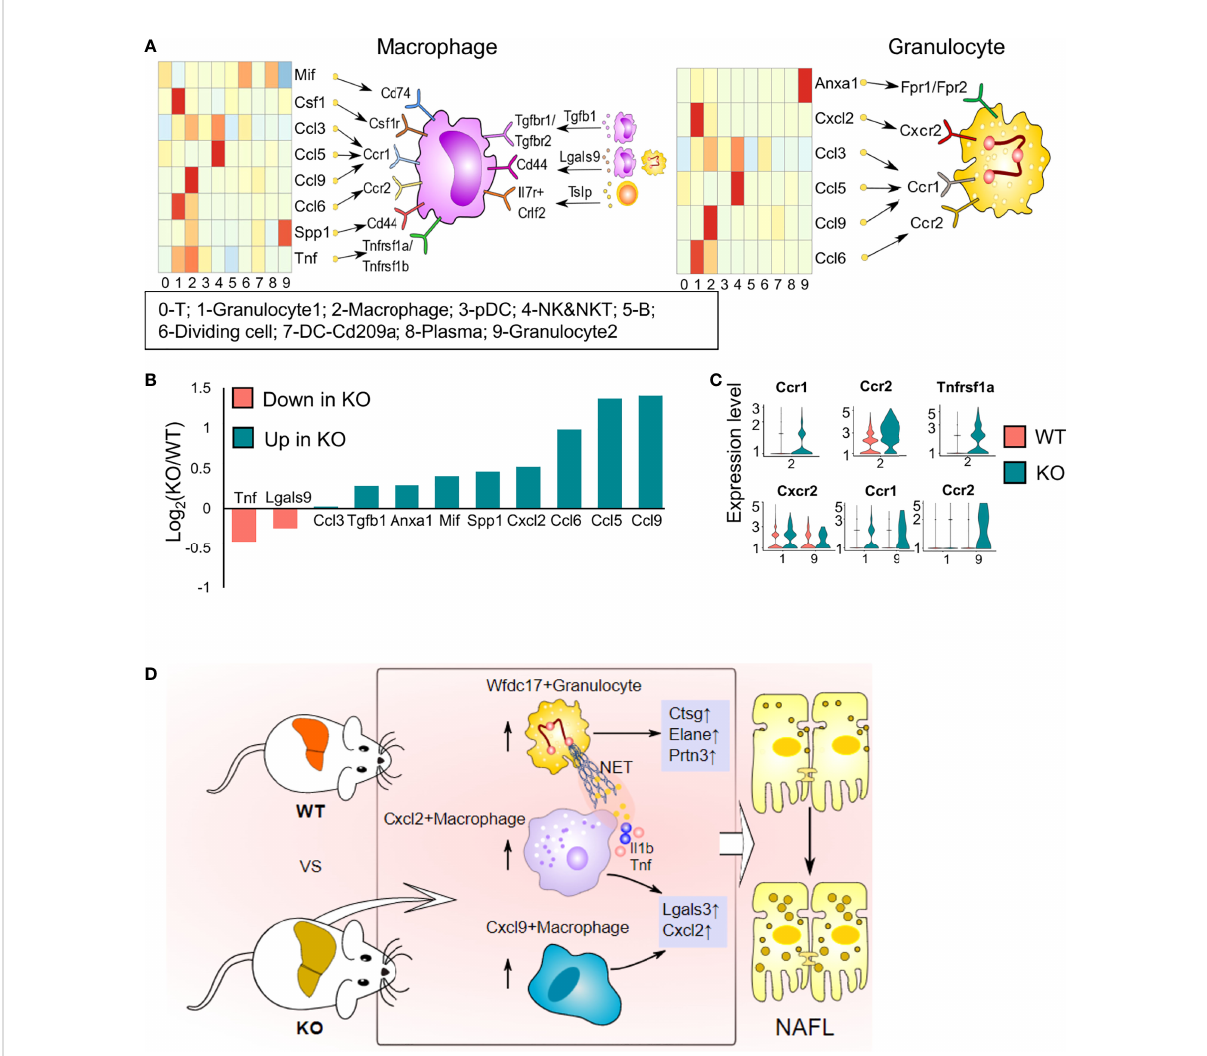
FIGURE 8 Cell – cell interaction plots according to receptor – ligand analysis using CellChat and the effects of ApoA4 on the immune microenvironment in NAFL livers. (A) Signal interaction between macrophages and other cell types (left) and signal interactions between granulocytes and other cell types (right). (B) Average expression values of ligands shown in (A) in WT and KO NAFL livers based on the scRNA-seq dataset. (C) Violin plots showing values of receptors in (A) in WT and KO NAFL livers based on the scRNA-seq dataset. (D) Pro fi ling of the effects of ApoA4 deletion on the immune microenvironment in NAFL and its potential mechanisms, as described in the discussion. Wfdc17 + granulocyte: 0-Gran-Wfdc17; Cxcl9 + macrophage: 4-M j -Cxcl9; Cxcl2 + macrophage: 4-M j -Cxcl2; NET: neutrophil extracellular